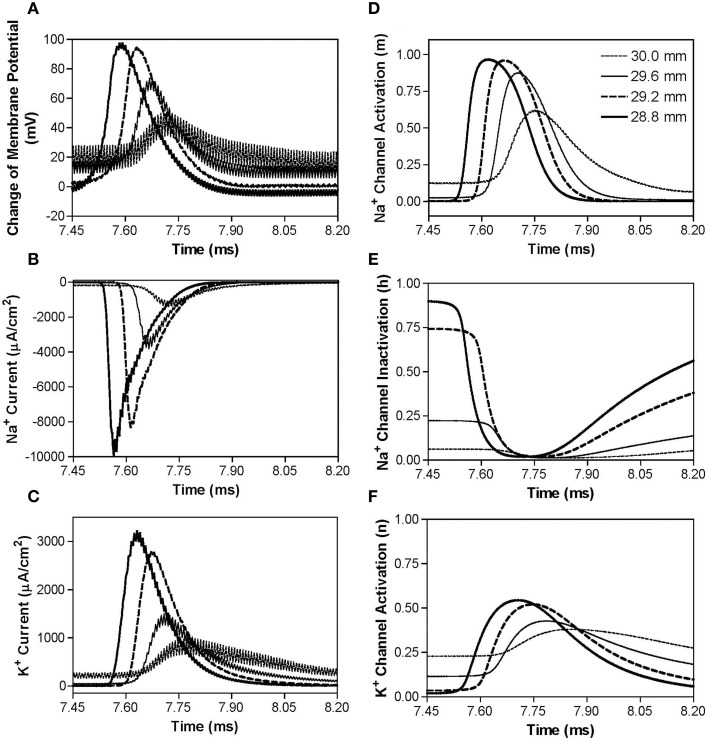
The changes in membrane potential, ionic currents, and activation/inactivation of ion channels near the block electrode when conduction block is induced by a 120 kHz non-symmetric waveform with the negative pulse 1 μs longer than the positive pulse. The legends in (D) indicate the locations along the axon. The location at 30.0 mm is under the block electrode. (A) Change in membrane potential, (B) Na+ current, (C) K+ current, (D) Na+ channel activation, (E) Na+ channel inactivation, (F) K+ channel activation. Non-symmetric stimulation waveform: 120 kHz, 8.7 mA. Axon diameter: 2 μm. Abscissa: time in ms after the start of blocking stimulation.